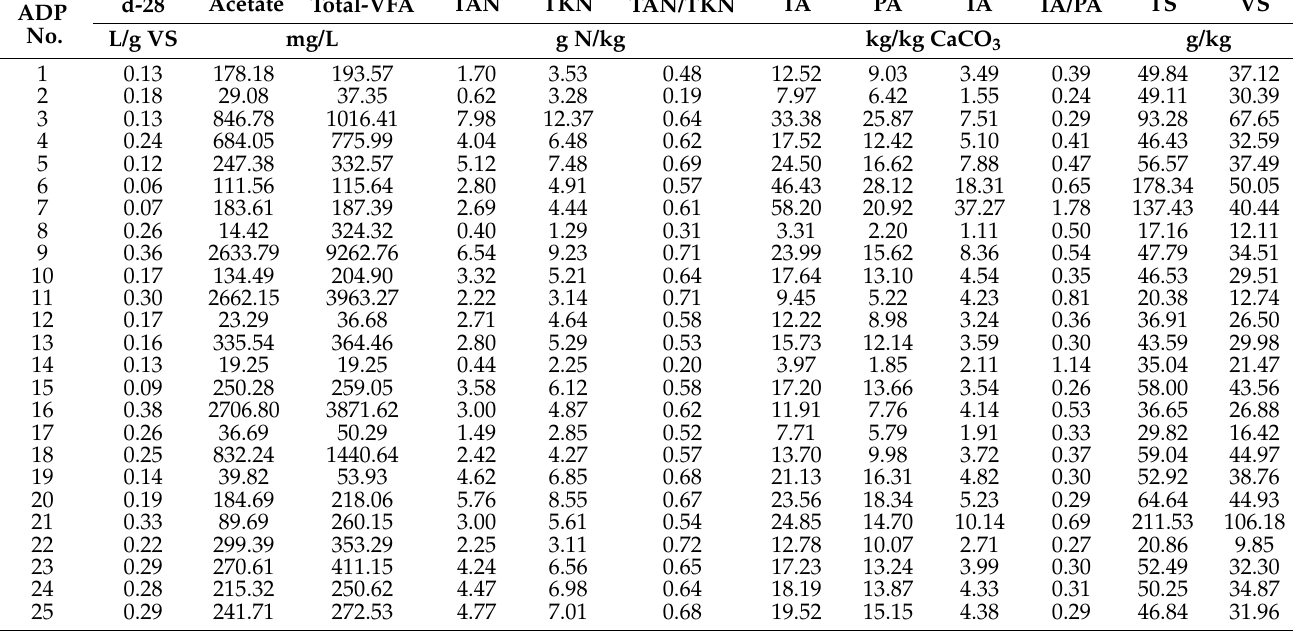
Table 1. RBP test results on day 28 (d-28) and the physicochemical characteristics of 25 samples (Part